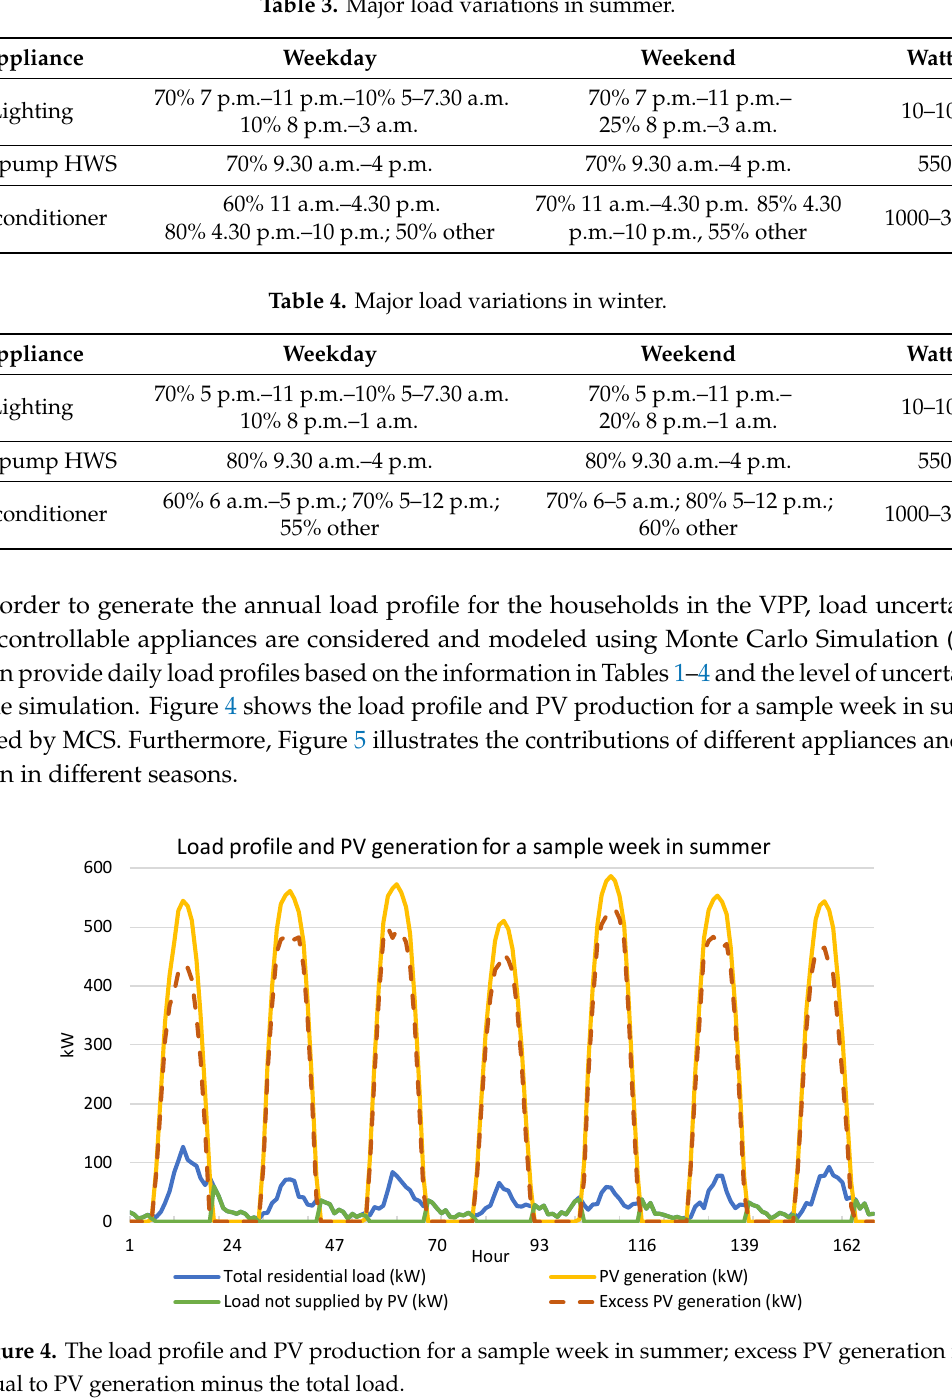
Table 3. Major load variations in summer.